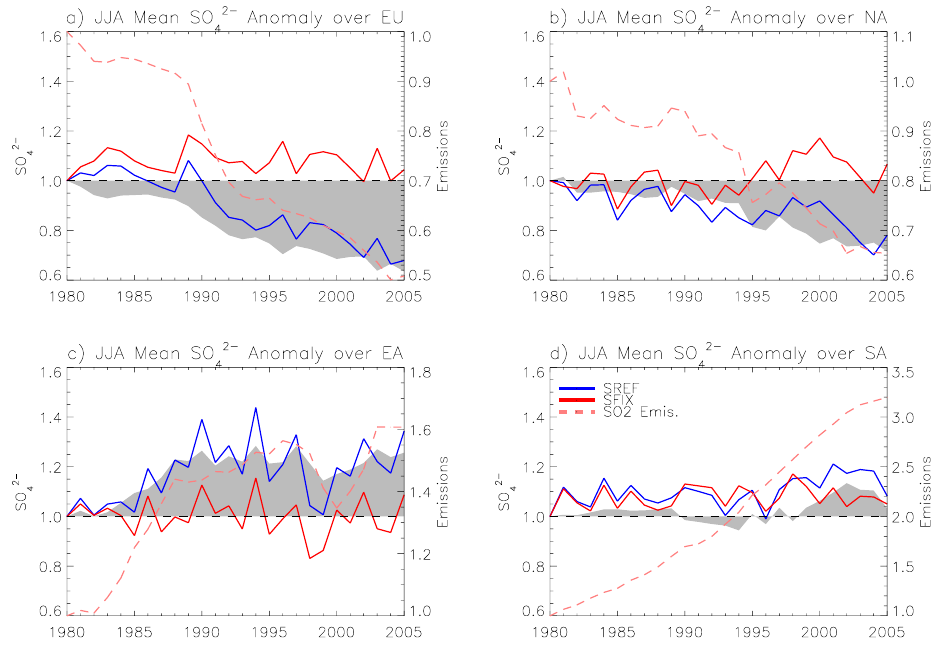
Fig. 12. As Fig. 11 for summer (JJA) anomalies of surface SO 2 −